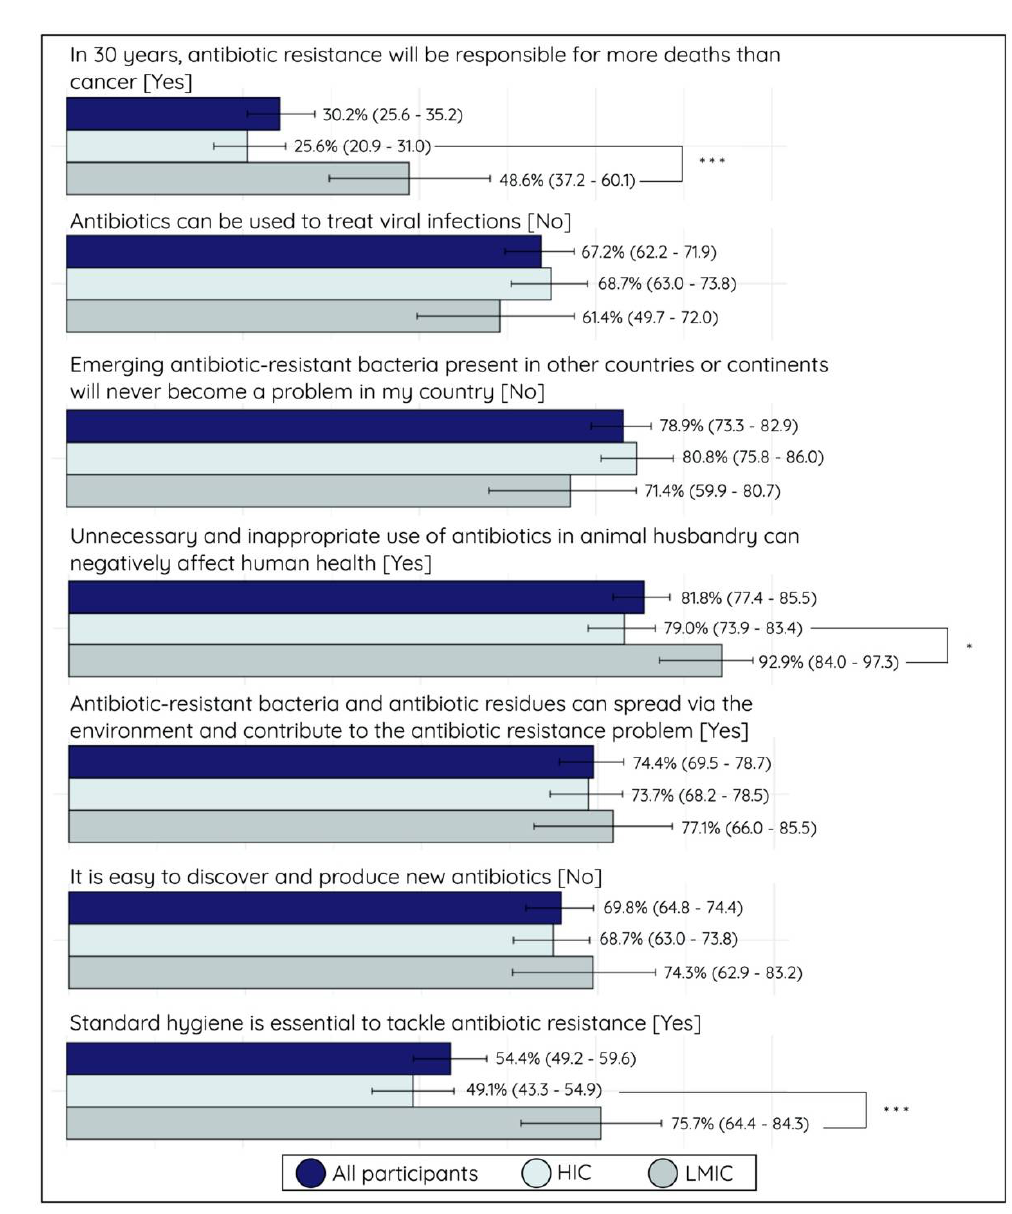
Figure 2. Bar plot (proportion of questions correctly answered, with 95% confidence intervals) of knowledge of questions of all participants, stratified for high-income country (HIC) and low- and middle-income country (LMIC) participants. The correct answer option (yes/no) is shown behind each statement, with “yes” corresponding to agree and strongly agree and “no” to disagree and strongly disagree with the survey statements. Significance: *** p < 0.001, and * p <